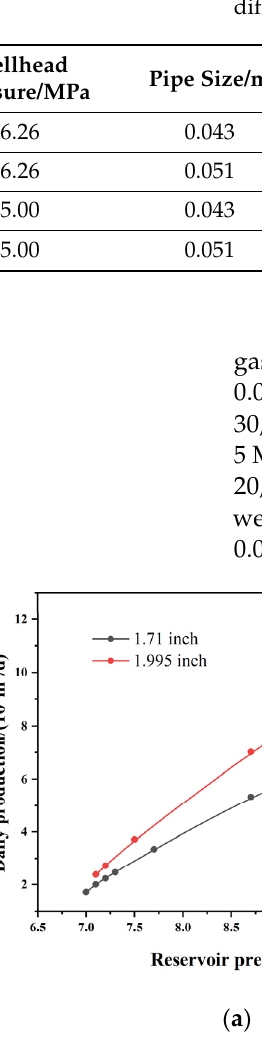
Figure 9. ( a ) Relationship between formation pressure and daily production for wellhead pressure of 6.26 MPa. ( b ) Relationship between formation pressure and daily production for wellhead pressure of 5 MPa.